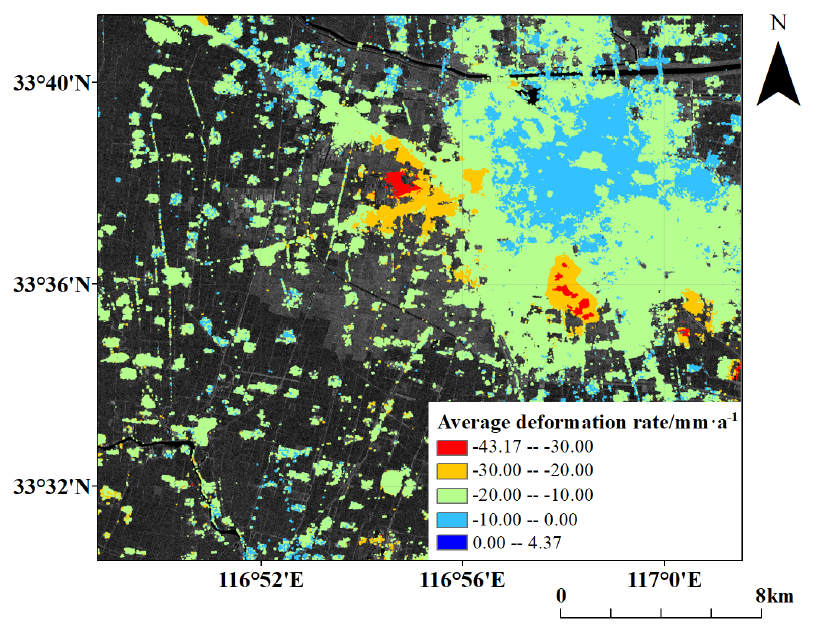
Figure 6. Distribution of deformation rate in the study area from June 2017 to July 2020 based on